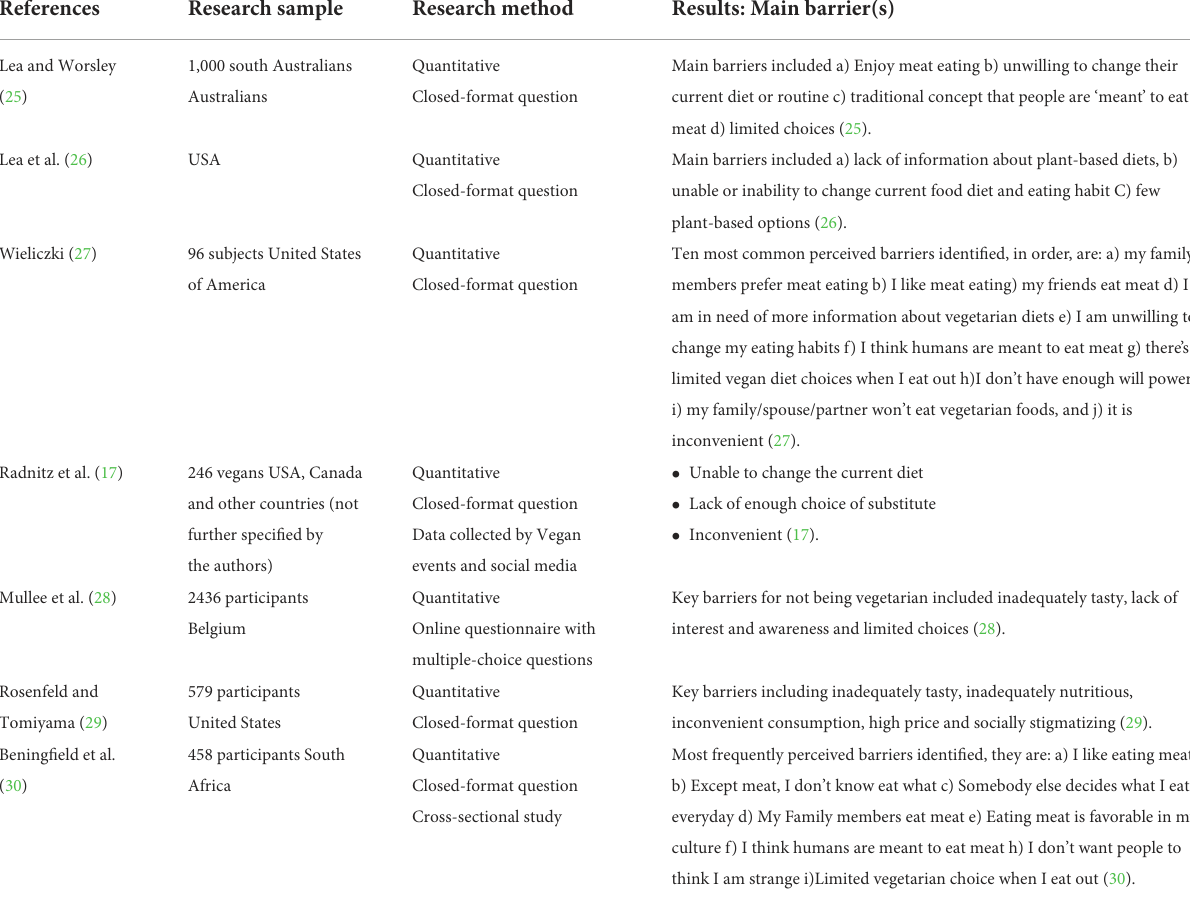
TABLE 2 List of previous research on the barriers to vegetarian